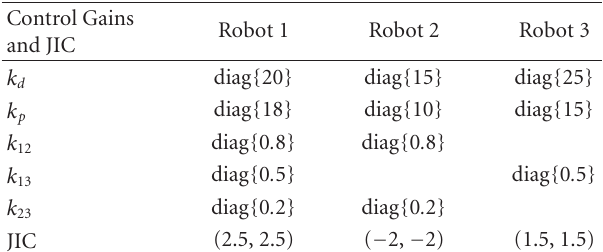
Table 1: Control